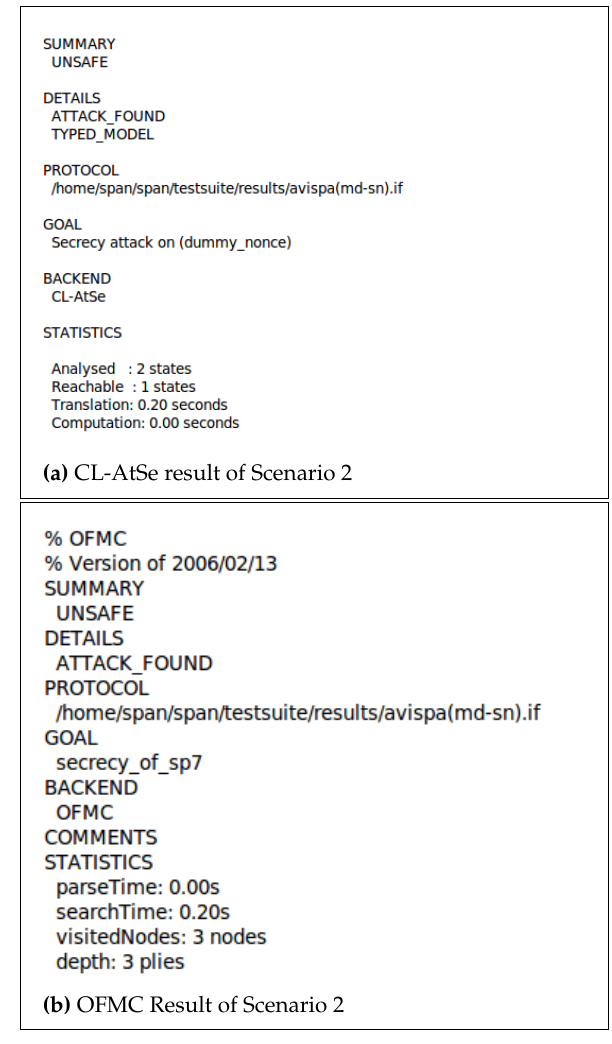
Figure 13. Simulation result of Scenario